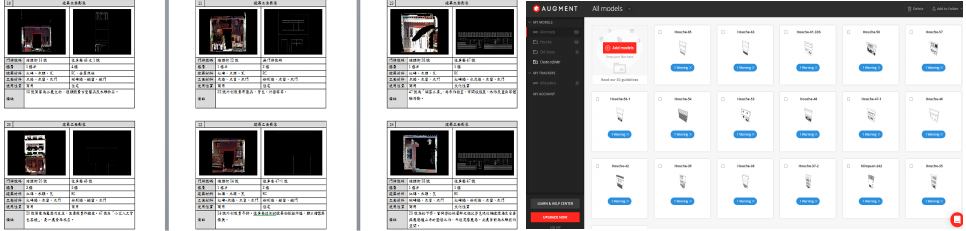
Figure 9. A collection of paired façades on the opposite side of the same street block ( left ) and the model list in Augment ® ( right ).